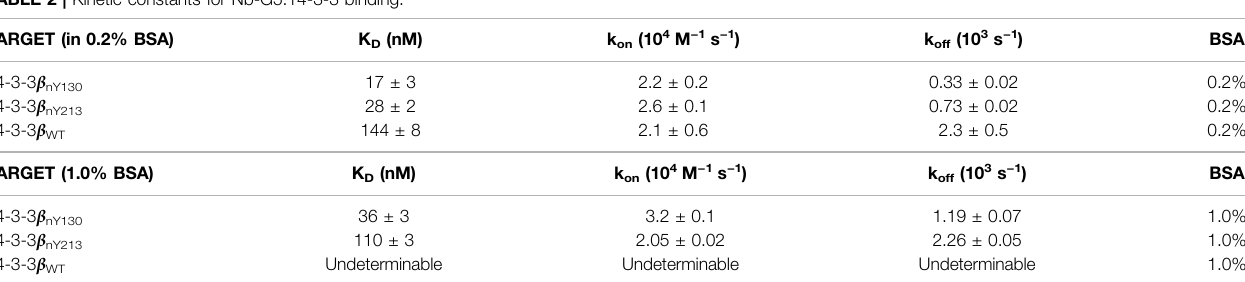
TABLE 2 | Kinetic constants for Nb-G5:14-3-3 binding. TARGET (in 0.2%